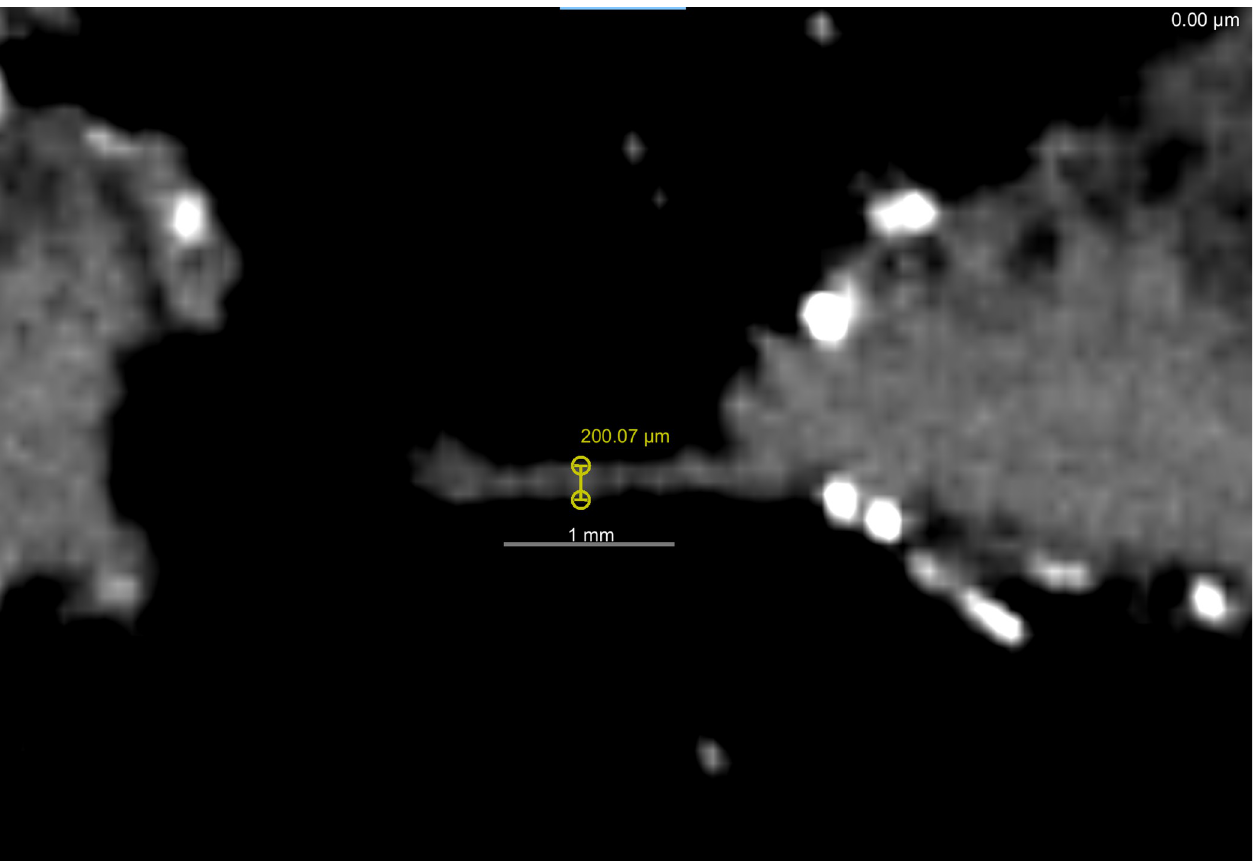
Fig 3. Digital visiualization of the posterior incision and stitching. Micro-CT image of a thread reaching across the posterior incision. Note the width (200 μ m) and the fraying at the left end indicating that this is a thread and not chambira fiber.